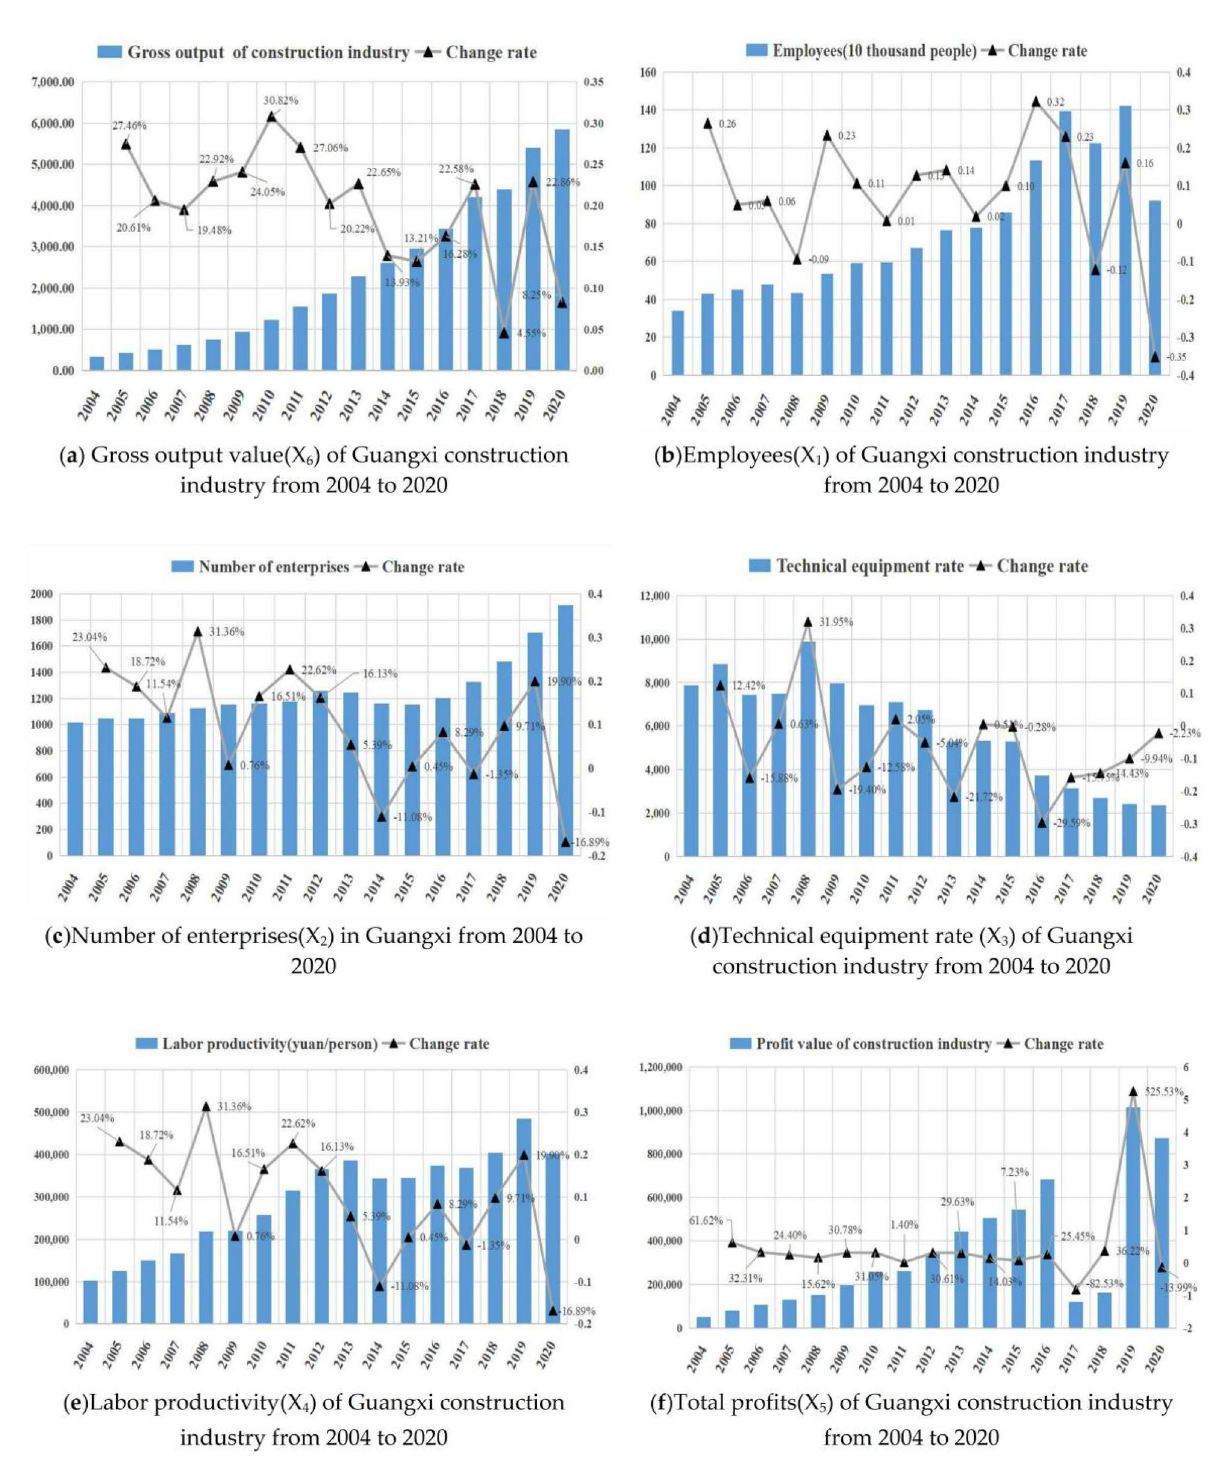
Figure 2. Various factors of Total factor productivity trend from 2004 to 2020:( a ) Gross output value(X 6 ) of Guangxi construction industry from 2004 to 2020;( b )Employees(X 1 ) of Guangxi construction industry from 2004 to 2020;( c )Number of construction enterprises(X 2 ) in Guangxi from 2004 to 2020;( d )Technical equipment rate (X 3 ) of Guangxi construction industry from 2004 to 2020;( e )Labor productivity(X 4 ) of Guangxi construction industry from 2004 to 2020;( f )Total profits(X 5 ) of Guangxi construction industry from 2004 to